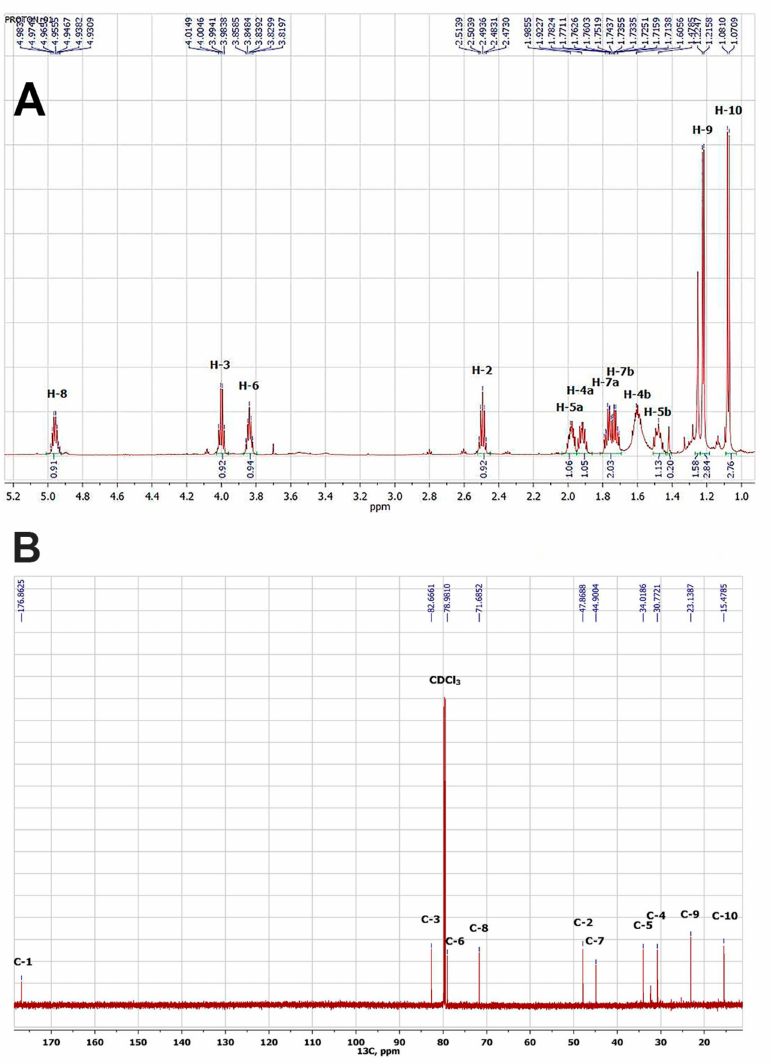
Figure 3. Spectra NMR 1 H of compound 1, CDCl 3 , 700 MHz ( A ) and NMR 13 C of compound 1, CDCl 3 , 175.8 MHz ( B